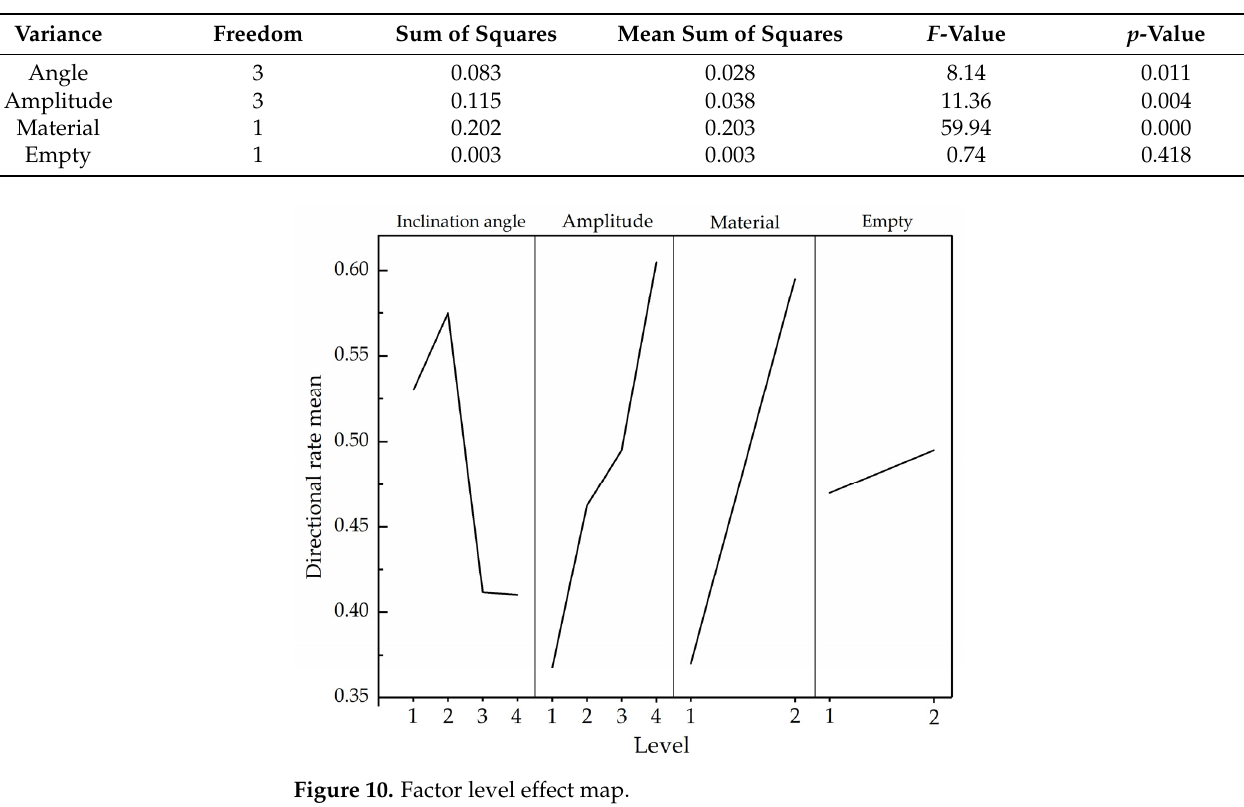
Table 4. Formula analysis table of various factors response average.